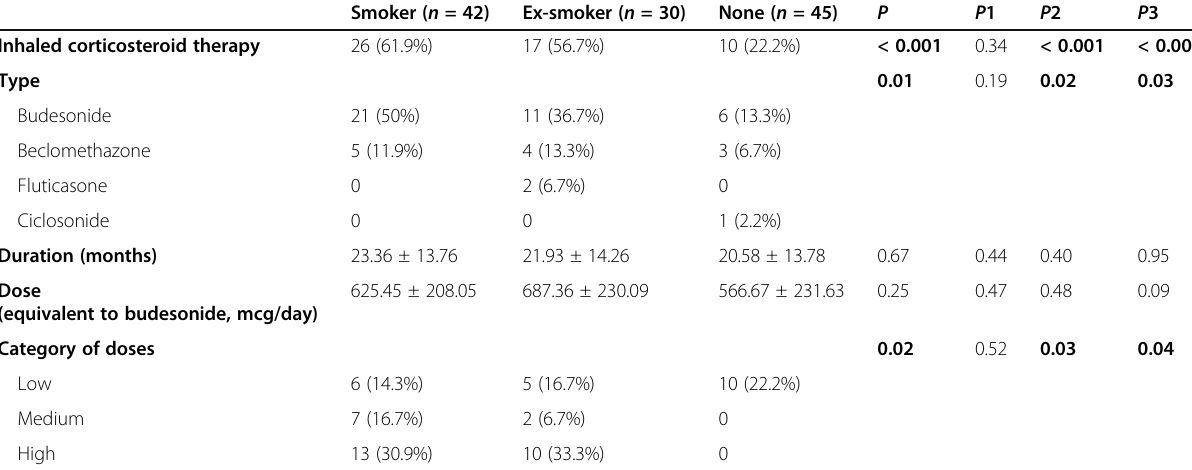
Table 2 Inhaled corticosteroid therapy among studied patients based on smoking status Inhaled corticosteroid